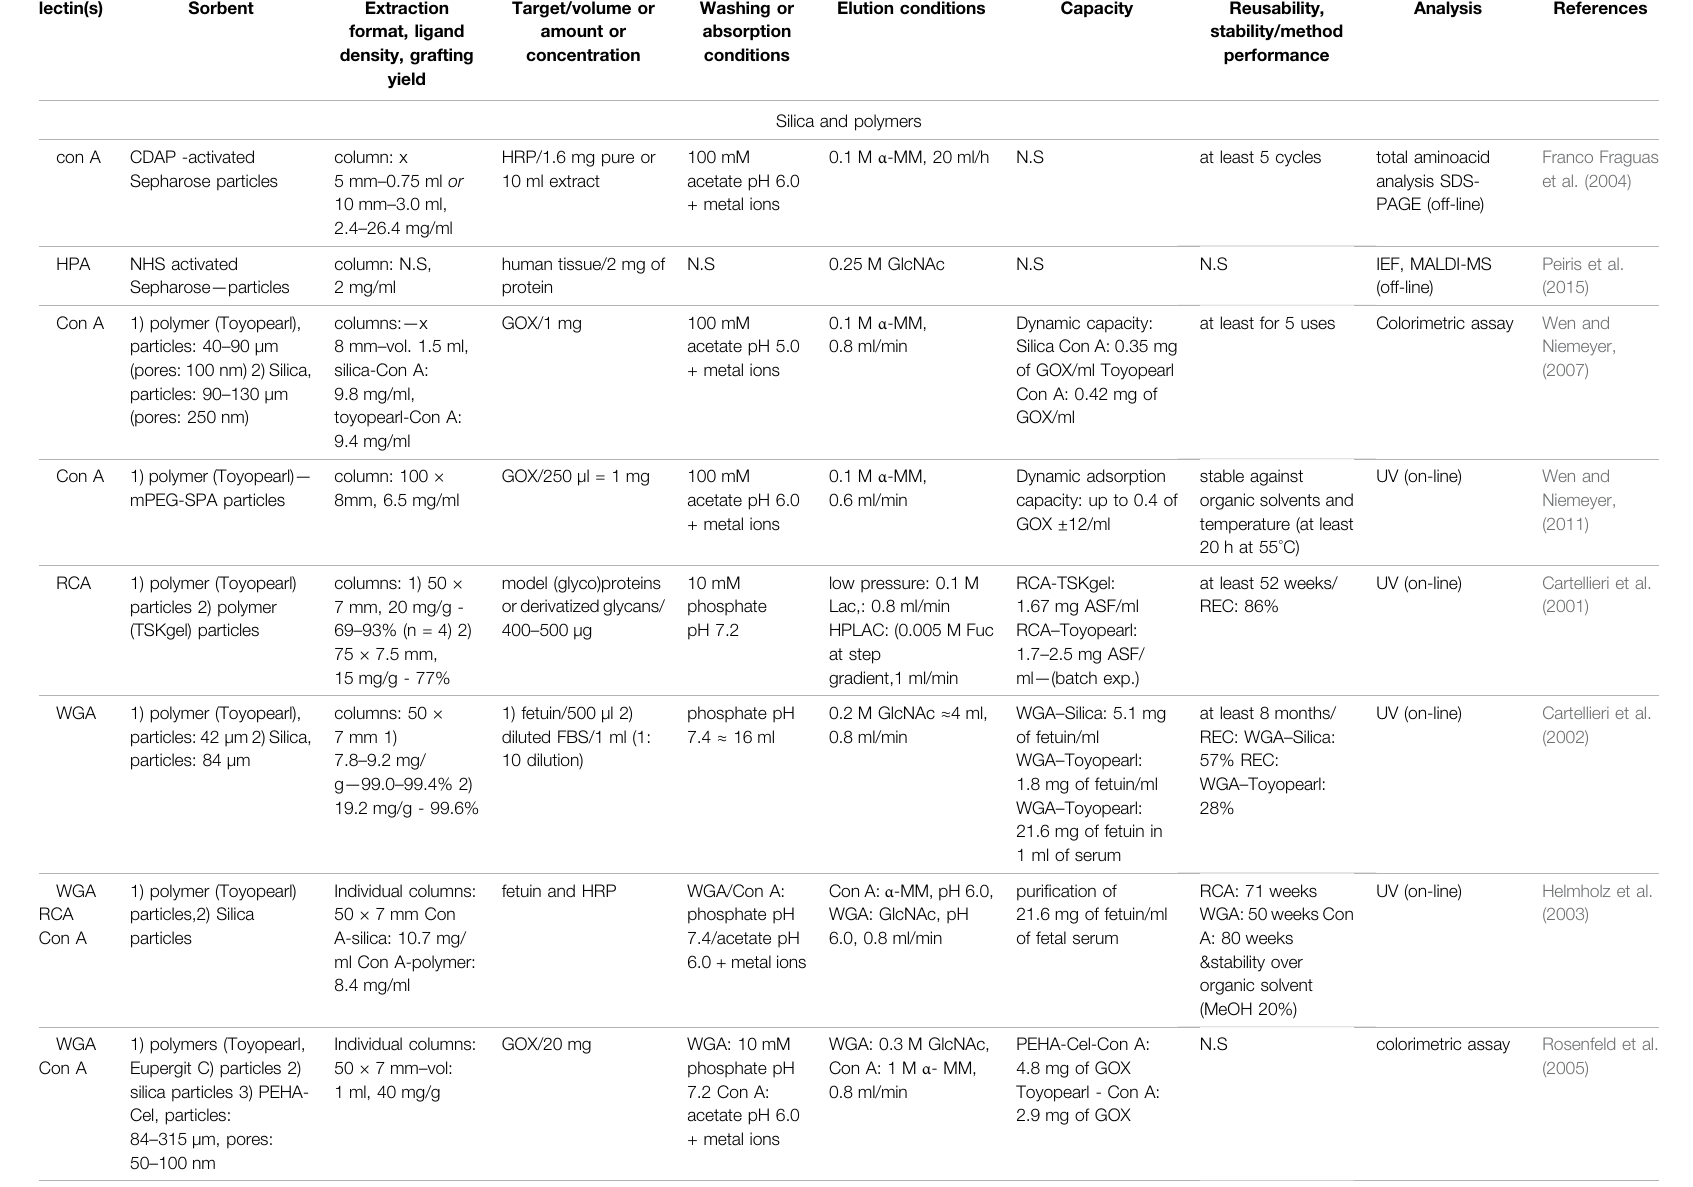
TABLE 4 | Lectin solid phase extraction using home-made sorbents.